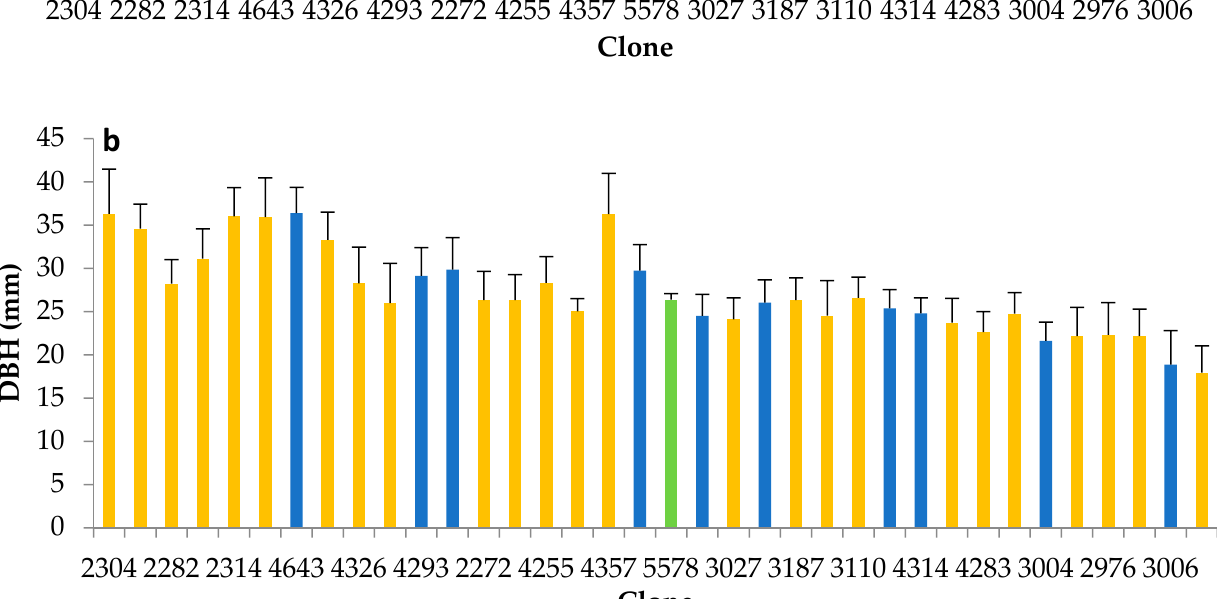
Table 4. Growth data (height and diameter at breast height (DBH)) (±SE) of balsam poplar in 2019 for all treatments (top 18 clones from treatment 1 and all clones from treatment 2 and treatment 3). Significant differences between treatment means are indicated by different letters.